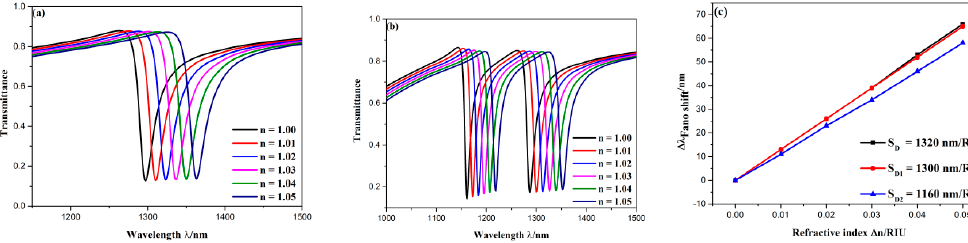
Figure 5. ( a ) Transmission spectra of 90° structure in diverse refractive-index; ( b ) transmission spectra of 45° structure in diverse refractive-index; ( c ) fitting line of sensitivity at D, D1, D2.